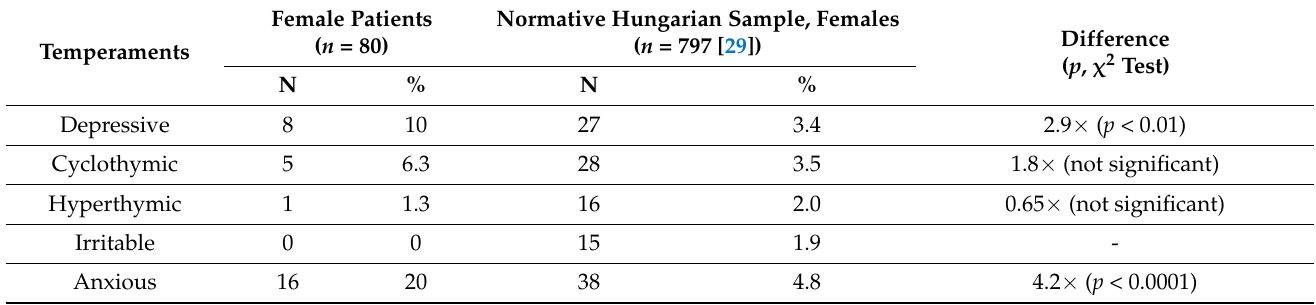
Table 2. Distribution of dominant affective temperaments (average score + 2 standard deviations (SD)) in our PD sample and in a large normative Hungarian